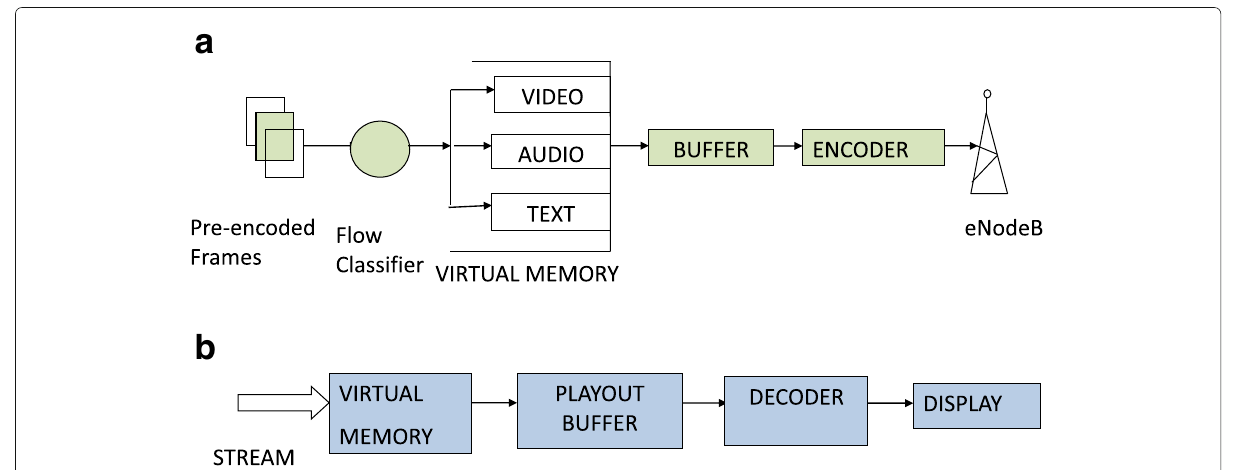
Fig. 1 VM architecture at both server and client. a Server section, b UE